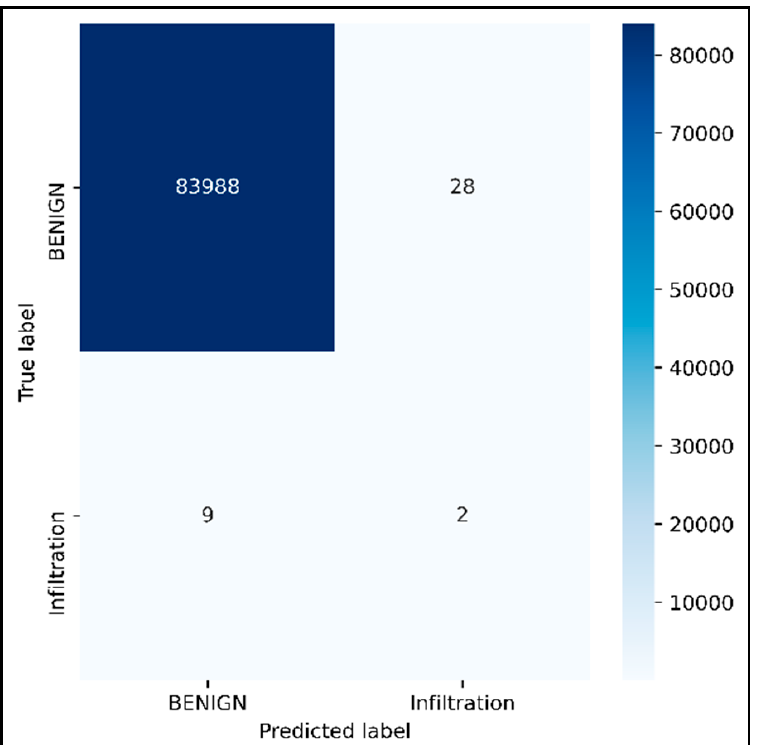
Figure 11. Thursday afternoon confusion matrix. Table 4. Statistical report of Tuesday test dataset.